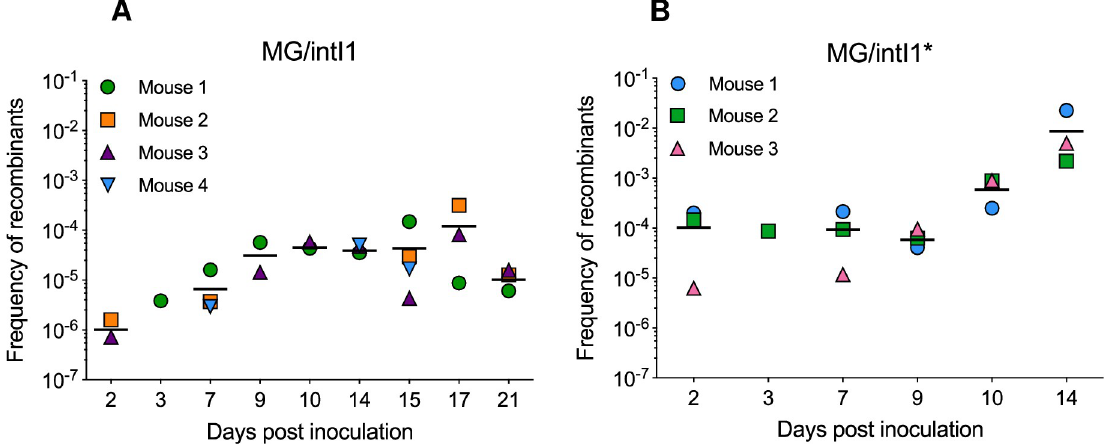
Fig 2. Recombination activity of IntI1 integrase in the mouse gut. On day 0, two groups of germ-free mice were inoculated with 10 8 CFU of MG/intI1 (carrying p6851 and pZE1intI1 allowing the expression of intI1 SOS-regulated, n = 4) (A) or MG/intI1 � (carrying p6851 and pZE1intI1 � allowing the constitutive expression of intI1 , n = 3) (B) . Recombination activity of IntI1, reflected by the frequency of recombinants (FR), was estimated by determining the frequency of emergence of tobramycin-resistant recombinants, as a result of specific recombination between attC sites located on a synthetic array of two cassettes ( attC aadA7 - cat(T4) - attC VCR2 -aac(6’)-Ib � ) carried on plasmid p6851. Each symbol represents the FR in the gut calculated from a single mouse exhibiting recombinants. For each sampling day, the average FR is shown as a black horizontal